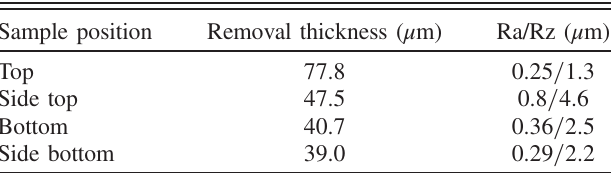
TABLE II. Removal thicknesses and surface roughness of the samples after lab